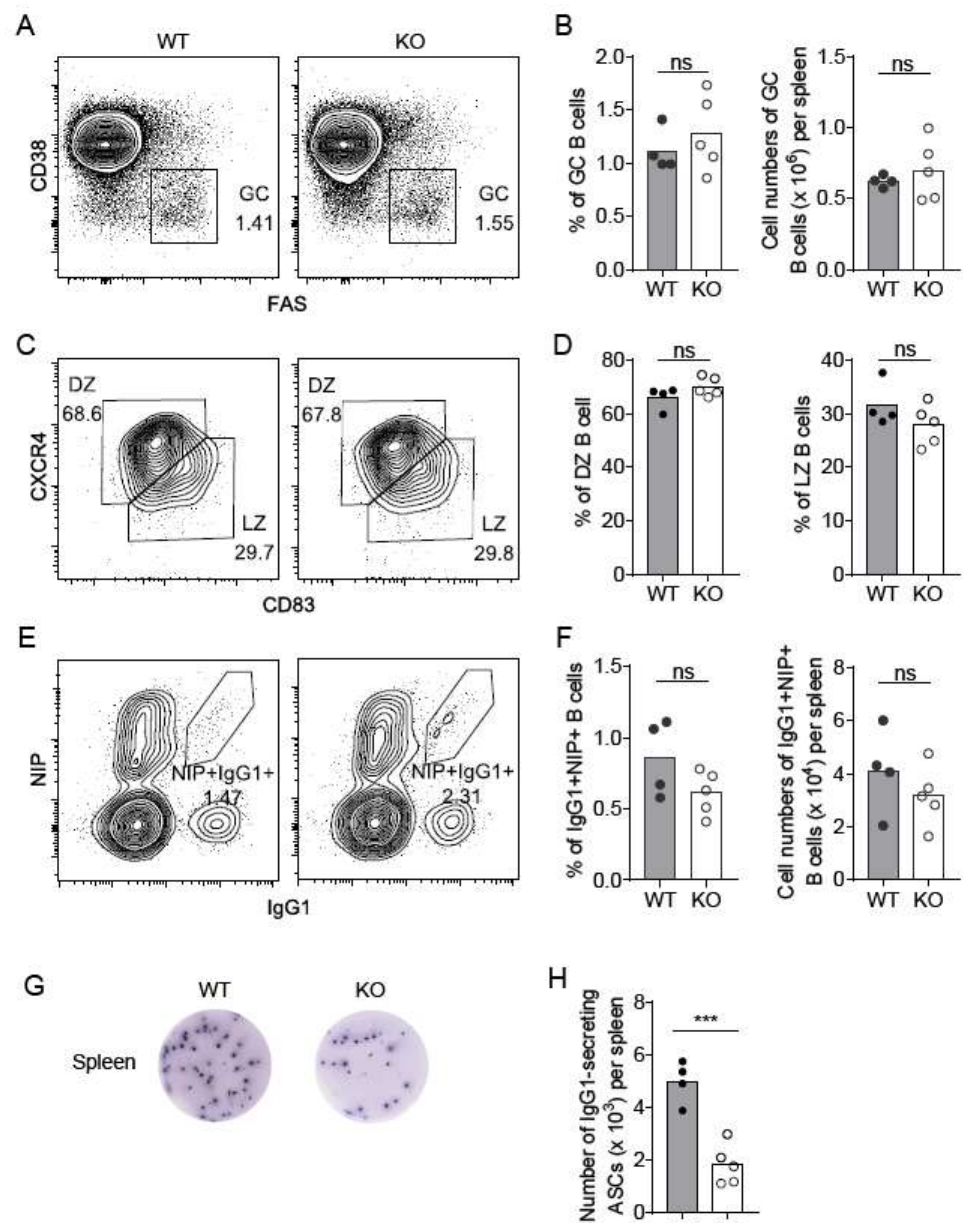
Figure 4. Nsun6 is dispensable in GC B cell response but important for antigen-specific ASC for- mation. ( A ) Flow cytometric analysis of the GC B cell (B220 + CD38 - FAS + ) in the spleen of WT and KO mice. ( B ) The ratio and number of GC B cells. ( C ) Flow cytometric analysis of DZ (B220 + CD38 - FAS + CXCR4 high CD83 low ) and LZ (B220 + CD38 - FAS + CXCR4 low CD83 high ) B cells. ( D ) The proportion of DZ and LZ B cells. ( E ) Flow cytometric analysis of NP-specific IgG1 + B cells (B220 + Dump [IgG, IgM, Gr-1, CD138, CD3] - NIP + IgG1 + ) in the spleen. ( F ) The ratio and number of NP-specific IgG1 + B cells. ( G ) ELISPOT assay anti-NP IgG1 Ab-secreting plasma cells in the spleen ( H ) Cell number of anti-NP IgG1 Ab-secreting plasma cells. In B , D , F , H , each dot represents an individual mouse. All mice were analyzed on day 10 post-immunization with NP-CGG. All data were from two independent experiments. In each statistical analysis, a two-tailed unpaired Student t -test was used. *** p < 0.001; ns, not significant ( p >